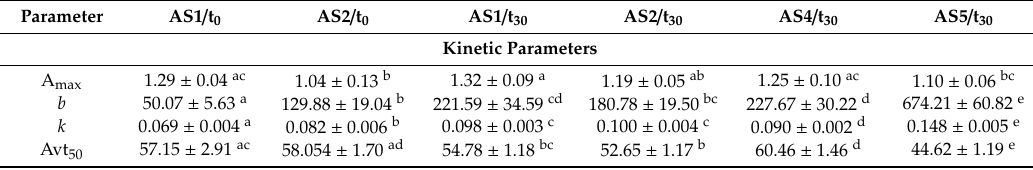
Table 4. The kinetic parameters for the AS in di ff erent experimental conditions.